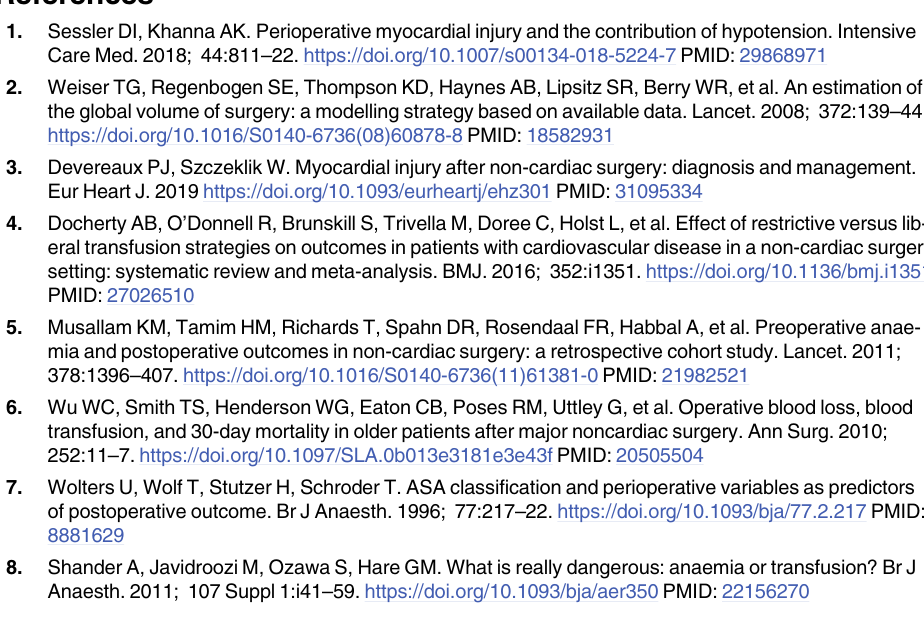
S3 Table. Baseline characteristics according to the actual hemoglobin decrease and intrao- perative transfusion. S4 Table. Baseline characteristics according to the actual hemoglobin decrease without regarding intraoperative transfusion. S5 Table. The incidence of myocardial injury after noncardiac surgery and mortality according to the actual hemoglobin decrease without regarding intraoperative transfusion. S6 Table. Sensitivity analysis of the effect of an unmeasured confounder on odds ratio of hemoglobin decrease for myocardial injury after noncardiac